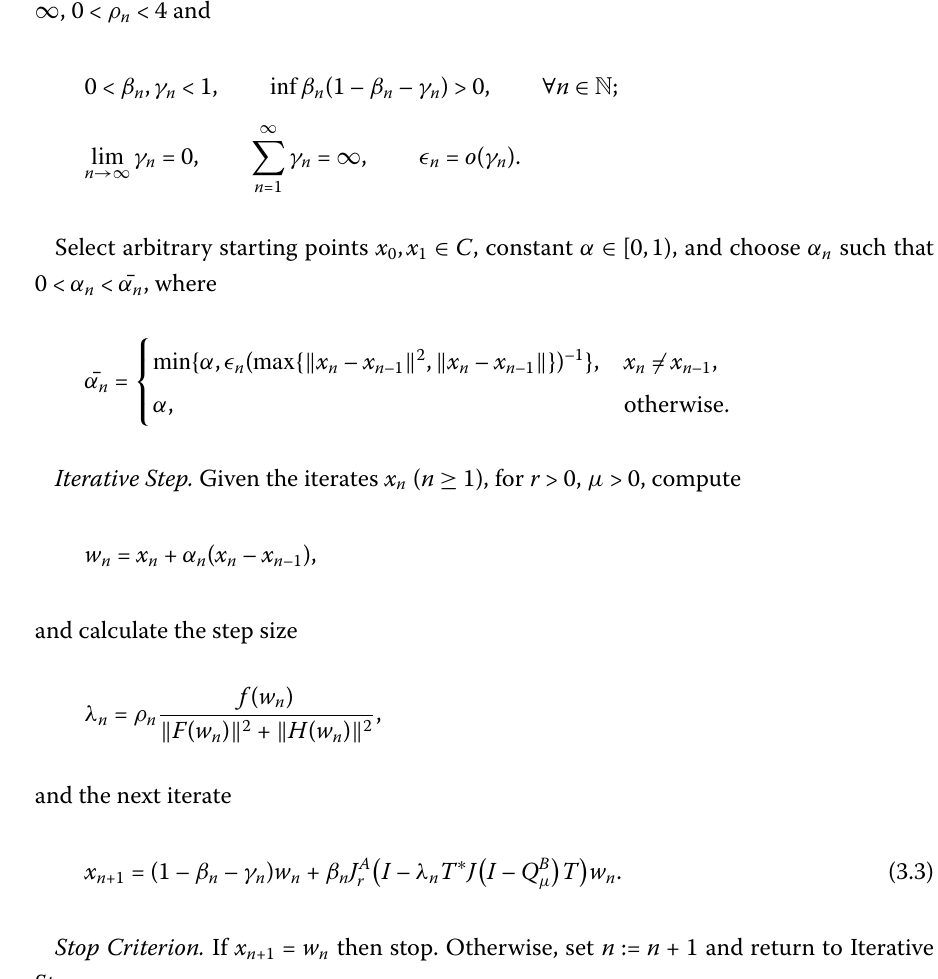
(cid:10) ∞ (cid:14) n n =1